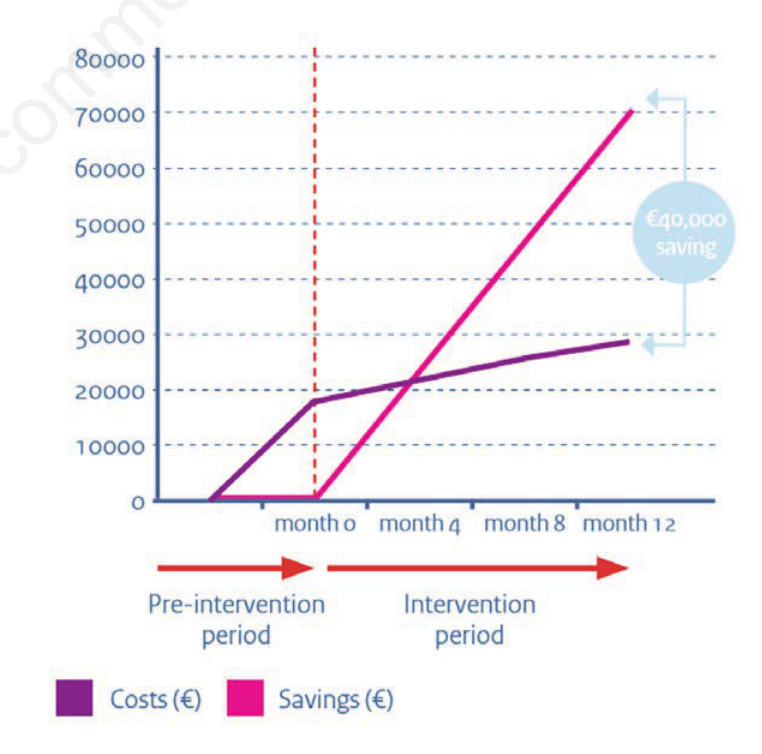
Figure 2. Costs and savings of the antimicrobial stewardship